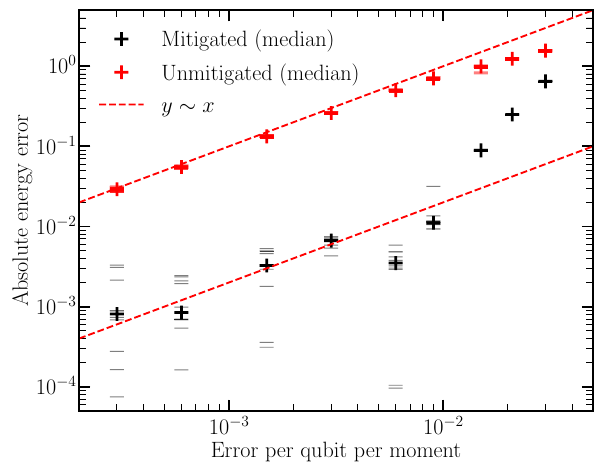
FIG. 5. Error in estimating the ground state energy of a four- site transverse-field Ising model [Eq. (62)] by variational opti- mization of a VHA ansatz. The resulting expectation values are measured either by verified single-control phase estimation (black) or taken directly from the simulated state (red). We plot the median (crosses) of the absolute energy error over ten opti- mization attempts, each starting from a different initial point. Individual errors are plotted behind (faint dashes). Guide lines showing a linear dependence are additionally plotted (red dashed